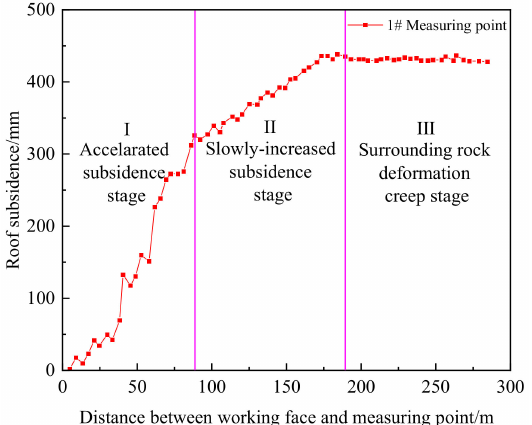
Figure 13. Roof dynamic subsidence value of measuring point 1 #